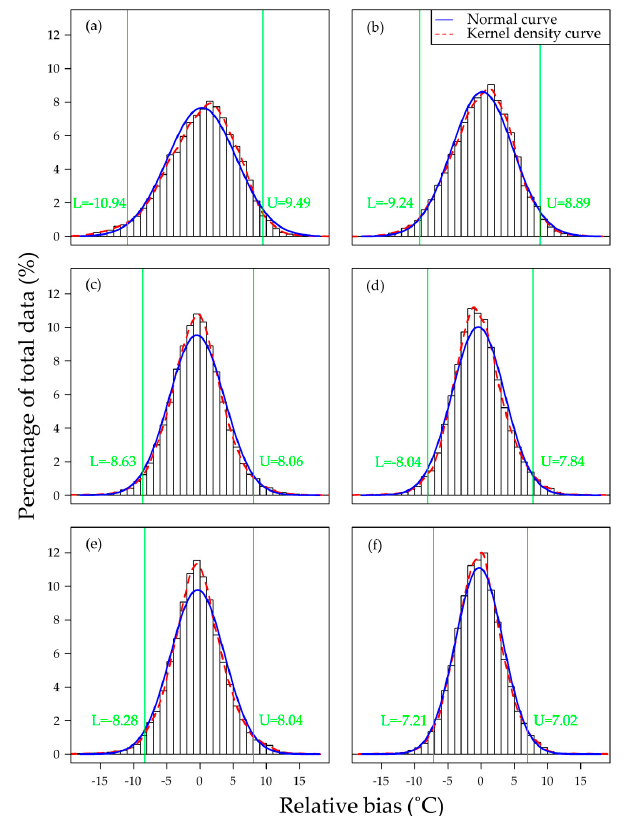
Figure 4. ( a – f ) Relative bias distribution considering all eight days T max (( a ) model 1, ( b ) model 7), T min (( c ) Model 8, ( d ) model 11) and T mean (( e ) model 12, ( f ) model 15). The blue curves are normal density distribution curves, red curves are kernel density distribution curves, and green lines show the lower endpoint and upper endpoint of the relative bias 95% confidence interval.